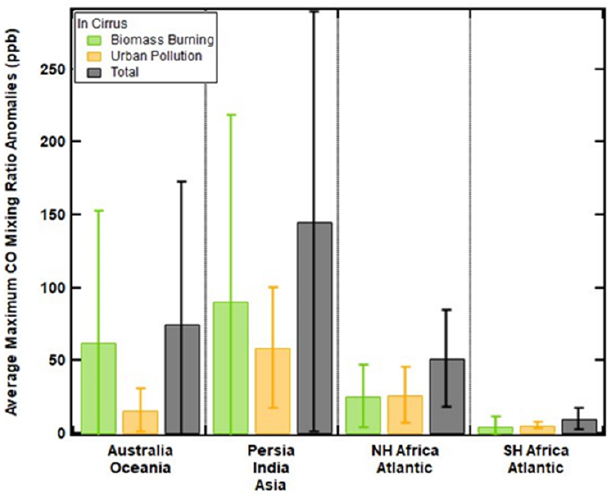
Figure 7. Similar to Fig. 4 but only for CO anomalies co-located with ice